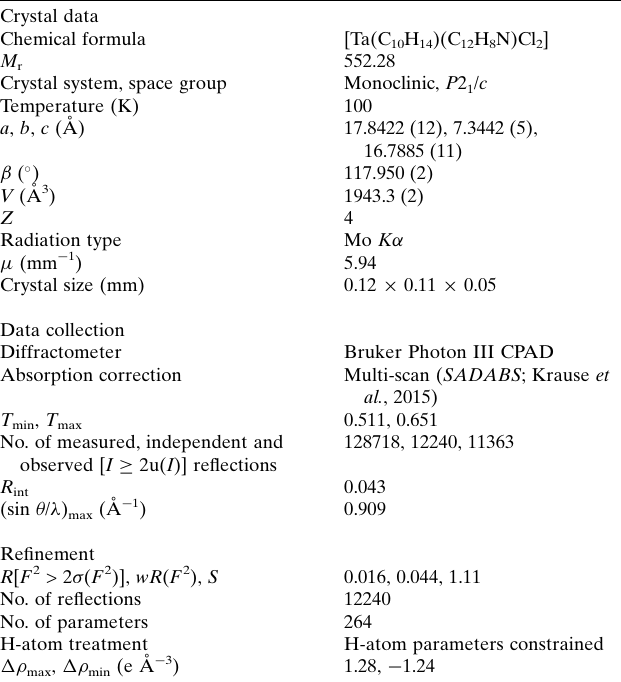
Table 2 Experimental details. Crystal data Chemical